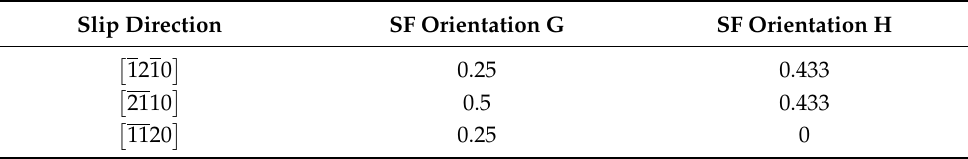
Table 2. Schmid factors (SF) for the respective slip directions for basal slip in crystals of orientations G and